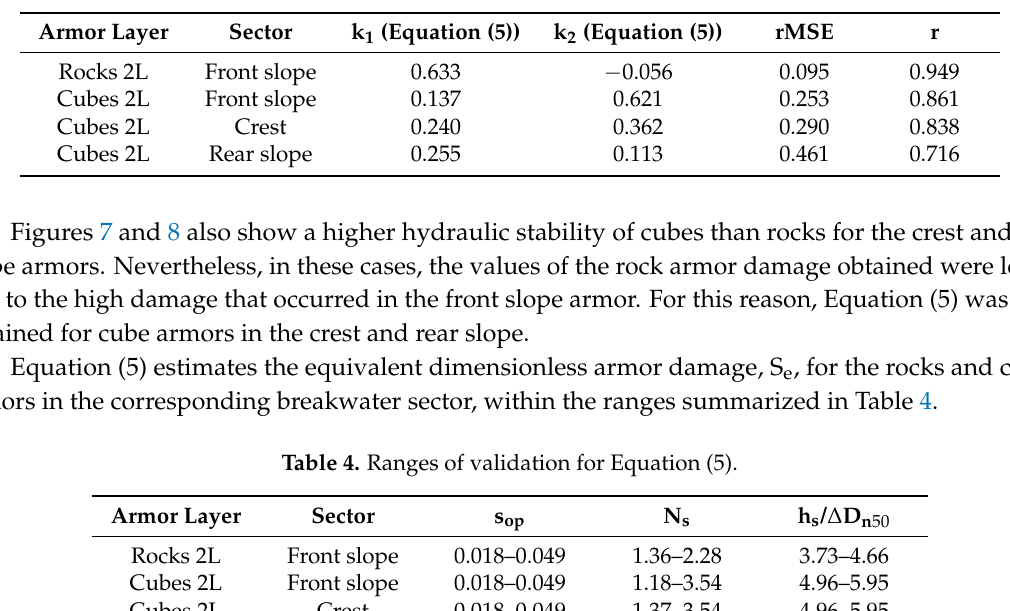
Figure 8. Measured armor damage, S e , in the rear slope as a function of the stability number (rock and cube armors).